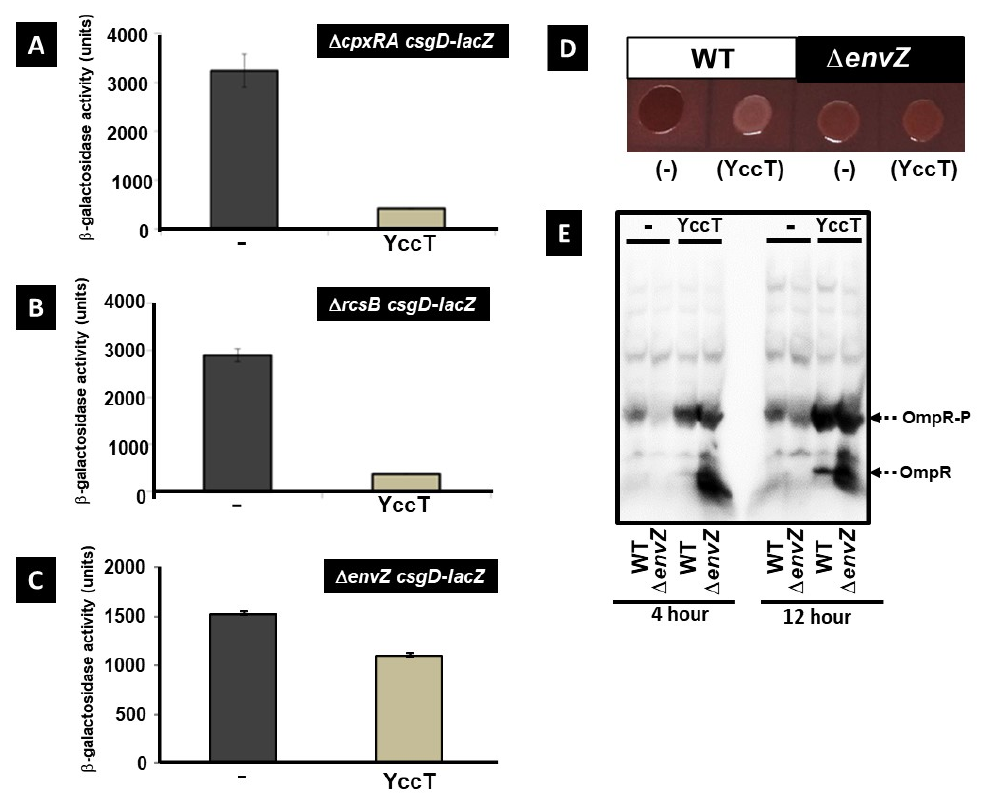
involved in the localization of YccT to the cellular poles and YccT and CsgA did not interact in the cytoplasm.